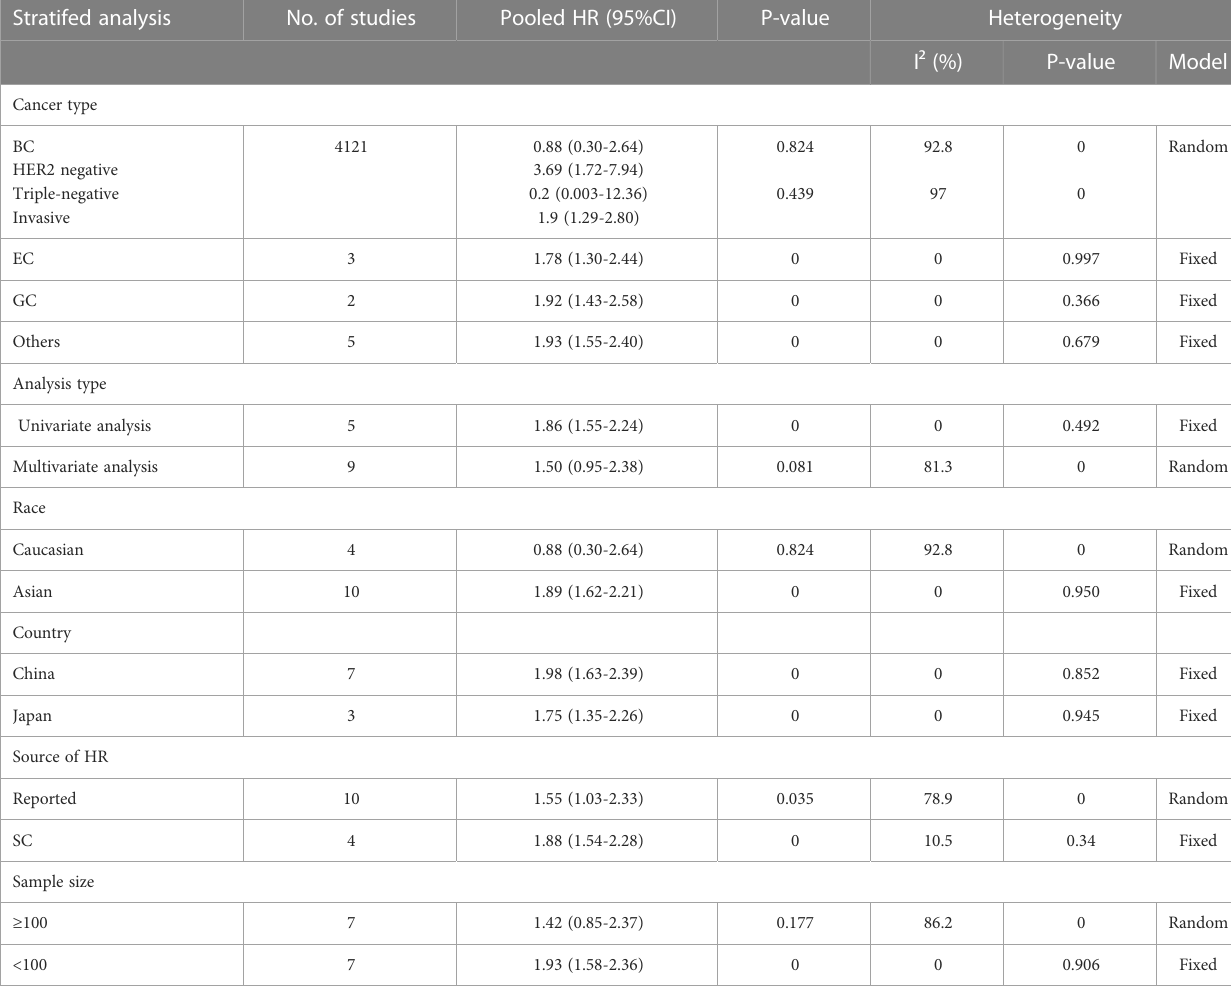
TABLE 2 Subgroup analysis for